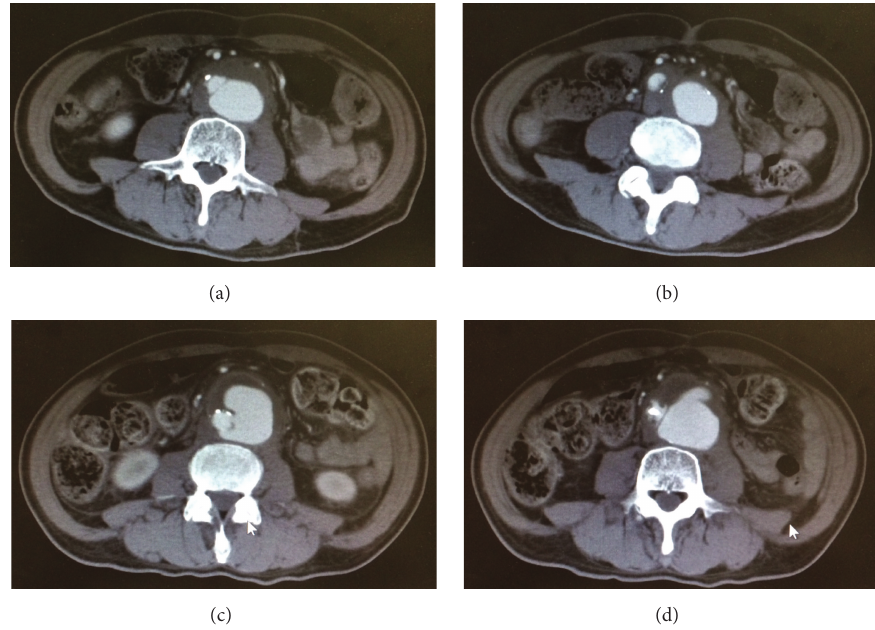
Figure 1: (a) and (b) Computed tomography scans taken during the patient’s initial examination. (c) and (d) Computed tomography scans taken on day 9 of the illness. We observed enlargement of the abdominal aortic aneurysm and thickening of the arterial wall.